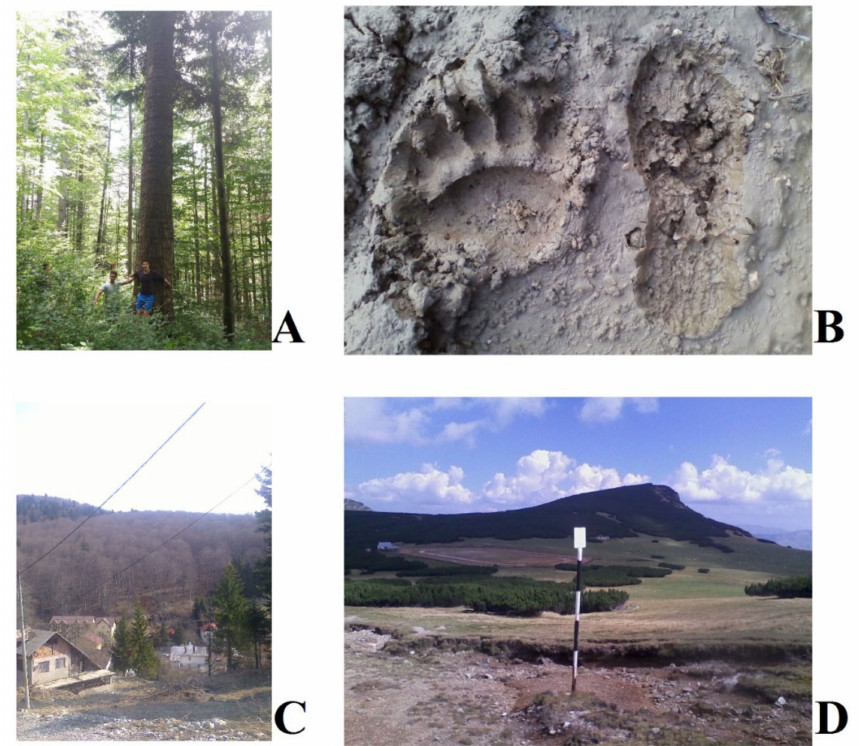
Figure 1. Landscape characteristics of the Prahova Valley which favour HWI—old growth forests and high quality large carnivore habitats on the eastern slopes of the Bucegi Mountains ( A , B ), sprawled periphery with households, yards and forest patches in the city of Bus heathlands due to intensive tourism activities on the Bucegi Plateau ( D